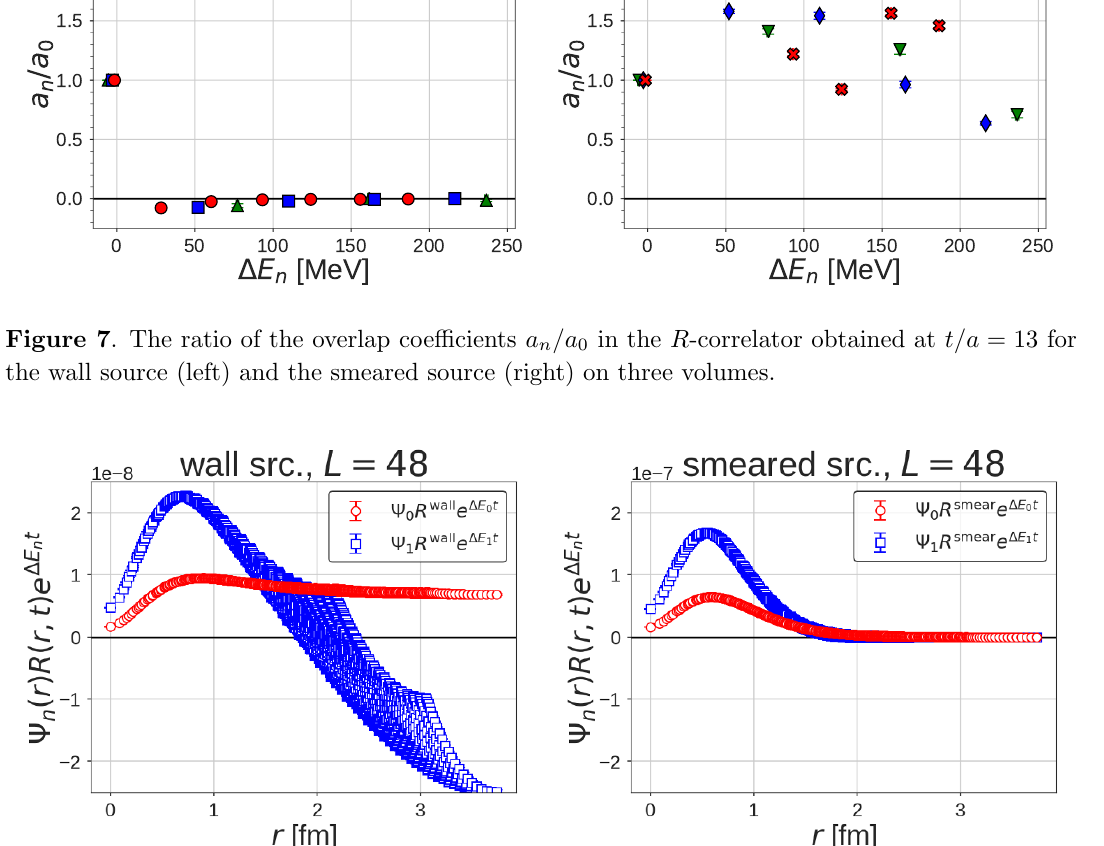
( ~r ) R ( ~r; t ) e (cid:1) E n t , as a n